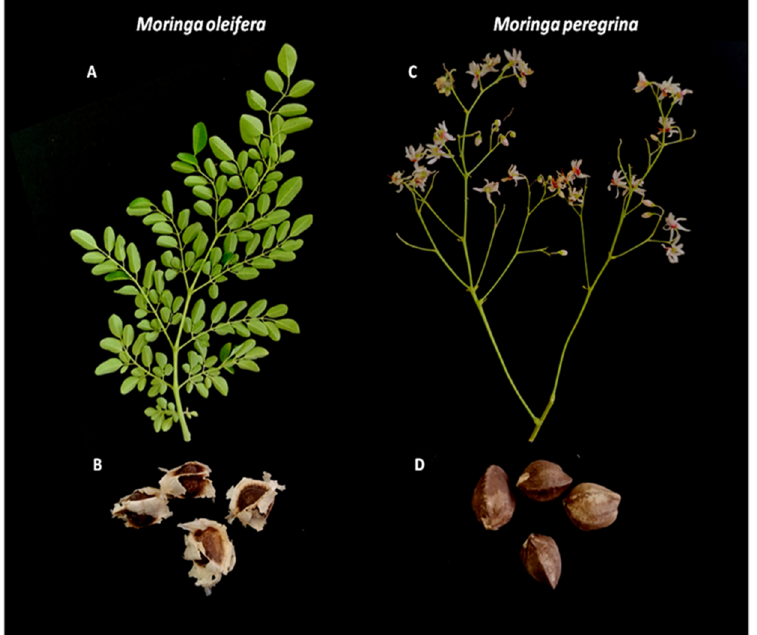
Figure 1. Leaves and seeds phenotype of M. oleifera and M. peregrina plants. (A and C) represent the leaves, (B and D) represent the seeds. Table 1. Proximate and mineral composition (%) from leaves and seeds of M. oleifera and M. peregrina .